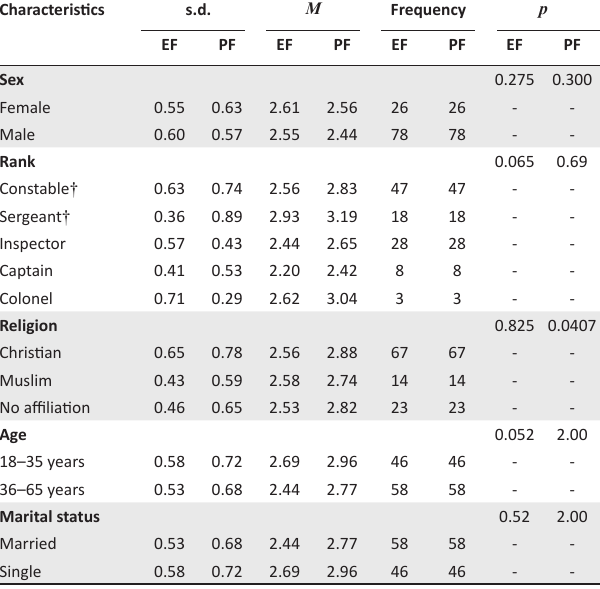
TABLE 6: Demographic characteristics of officers using emotionally focused and problem-focused coping strategies. Characteristics